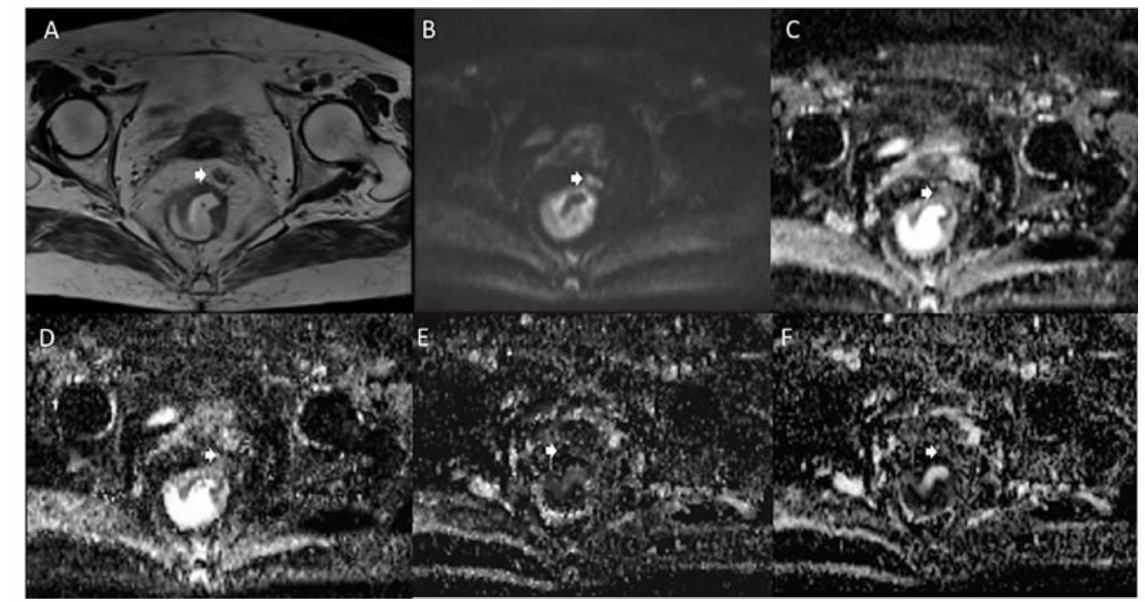
Figure 2. Woman 65 y.o. with rectal cancer. Tumor deposit (arrow) assessed in T2W sequence ( A ), in